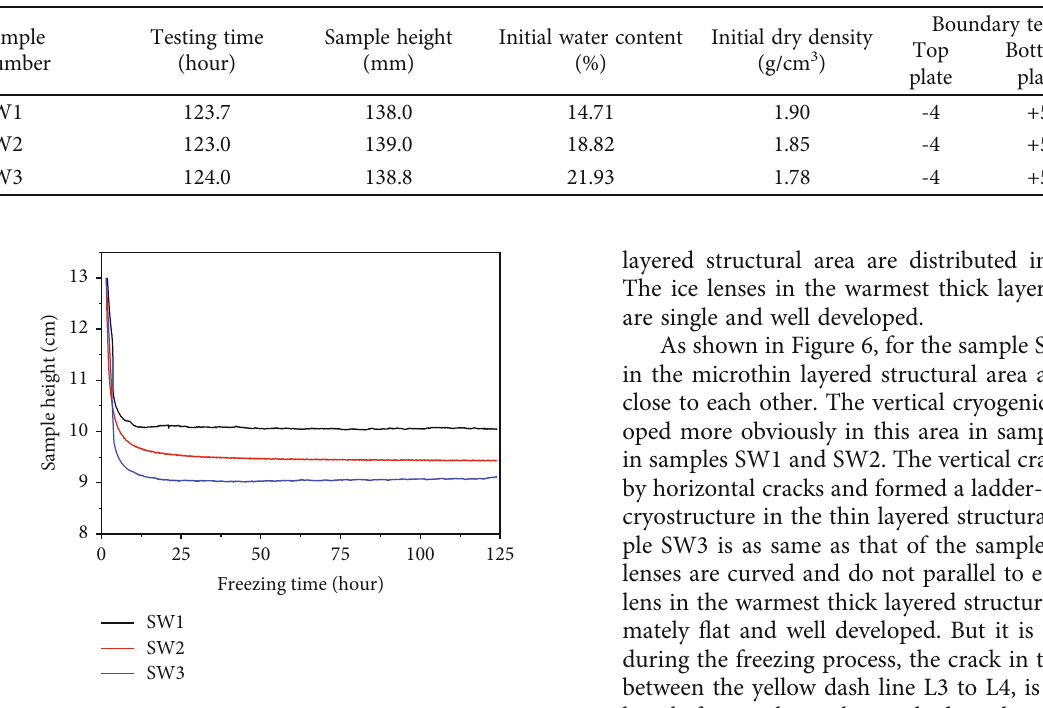
Figure 2: The freezing front movement in the samples.